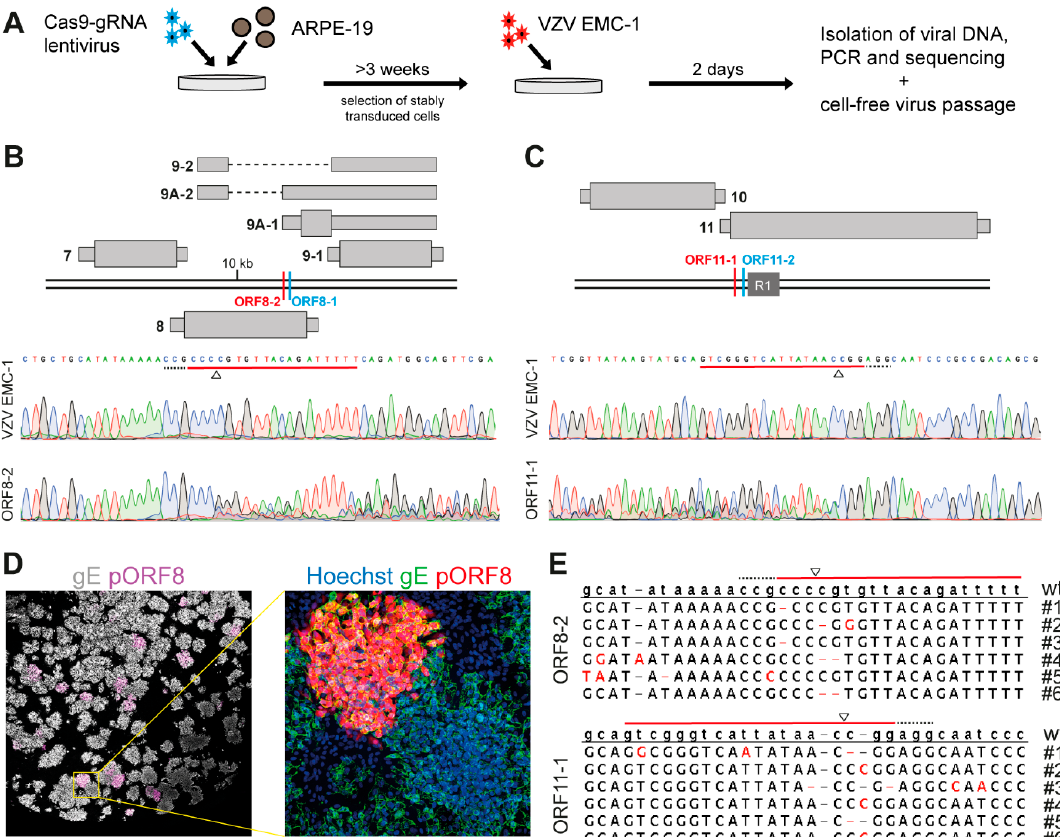
Figure 1. Editing of varicella-zoster virus (VZV) genomes using CRISPR/Cas9. ( A ) Experimental layout: ARPE-19 cells were transduced with a lentivirus encoding for both SpCas9 and a sgRNA, and selected for at least 3 weeks with appropriate antibiotics. Stably transduced cells were infected with cell-free VZV EMC-1 for two days, viral DNA was isolated and the target region was amplified by PCR and sequenced. ( B , C ) Top: Schematic illustration of the target region of ORF8 ( B ) and ORF11 ( C ): thick double black lines represent the VZV genome, currently annotated RNAs are depicted in grey—wide boxes are coding sequences (CDS), thin boxes are untranslated regions (UTRs) and dashed lines are intronic sequences—and DNA target sites of sgRNAs ORF8-1 and ORF8-2 ( B ) or sgRNAs ORF11-1 and ORF11-2 ( C ) are depicted. Bottom: Sanger sequencing traces showing the sgRNA target regions (red), PAM sequence (dashed black) and cleavage site with triangle for wild-type VZV EMC-1 DNA or from DNA extracted from VZV EMC-1 infected stably transduced ORF8-2 ( B ) and ORF11-1 cells ( C ). ( D ) Representative images of infected ARPE-19 cells with cell-free virus isolated from infected ORF8-2 cells stained by immunofluorescence for glycoprotein E (gray/green) and pORF8 (magenta/red). Nuclei were counterstained with Hoechst 33342 (blue), with 20 × magnification (left) or 200 × magnification (right). ( E ) Consensus Sanger sequences of 6 individual infectious foci after a single round of cell-free virus isolation and plaque purification following infection of stably transduced ORF8-2 (top) and ORF11-1 (bottom) cells. sgRNA target regions (red line), PAM sequence (dashed black line) and cleavage site with triangle are